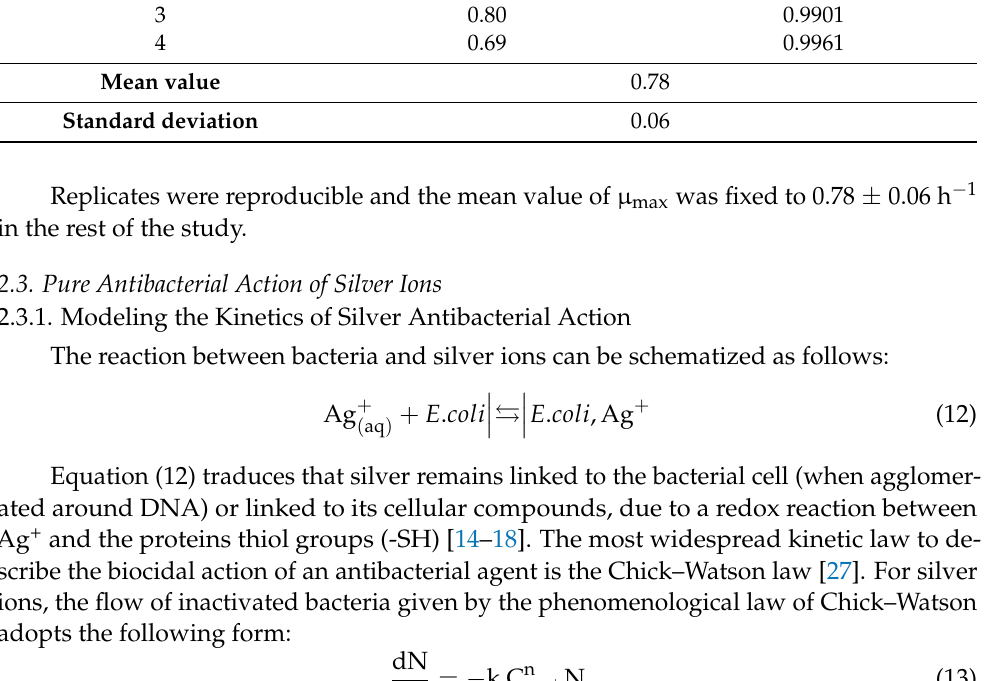
Table 2. Values obtained for the maximal growth rate (µ max ).